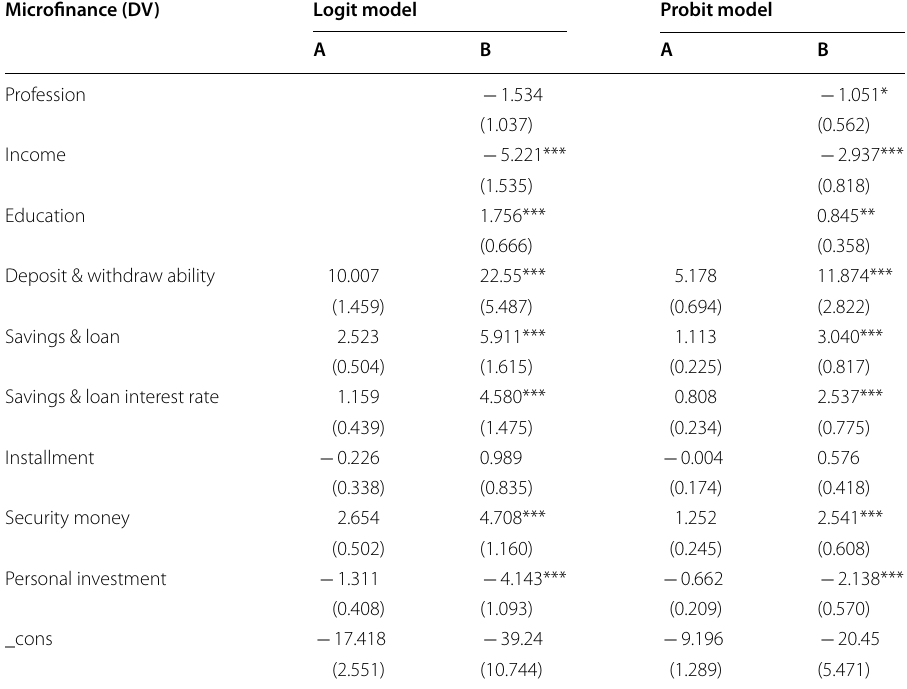
This model presents the association between financial literacy and microfinance access. Part A of the logit model shows 63.24 log-likelihood, LR chi 2 (6) is 1046.35, and model fits at 89% Pseudo R 2 value; where part B shows − log-likelihood, LR chi 2 (9) is 1085.41, and model fits at 93% Pseudo R 2 value. On the other hand, Part A of the Probit model shows 65.67 log-likelihood, LR chi 2 (6) is 1041.48, and the model fits at 88% Pseudo R 2 value; where part B shows − log-likelihood, LR chi 2 (9) is 1082.89, and model fits at 92% Pseudo R 2 value. The value of Prob > chi 2 is 0 for all models, and the observation of A & B is 852. ***, **, * refer significance level at 99%, 95%, 90%, respectively. The value within the first bracket is the standard error